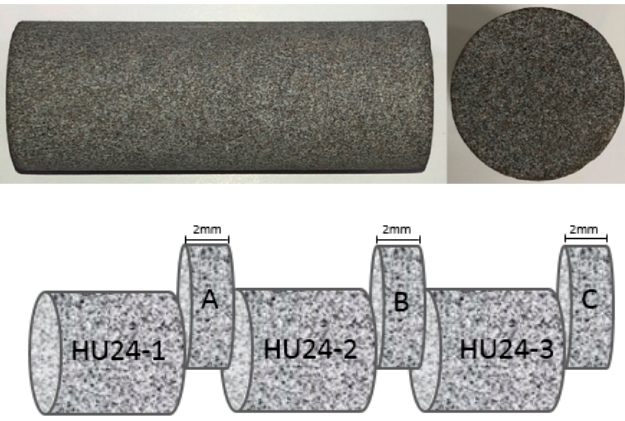
Figure 1. Schematic diagram of the core HU24.